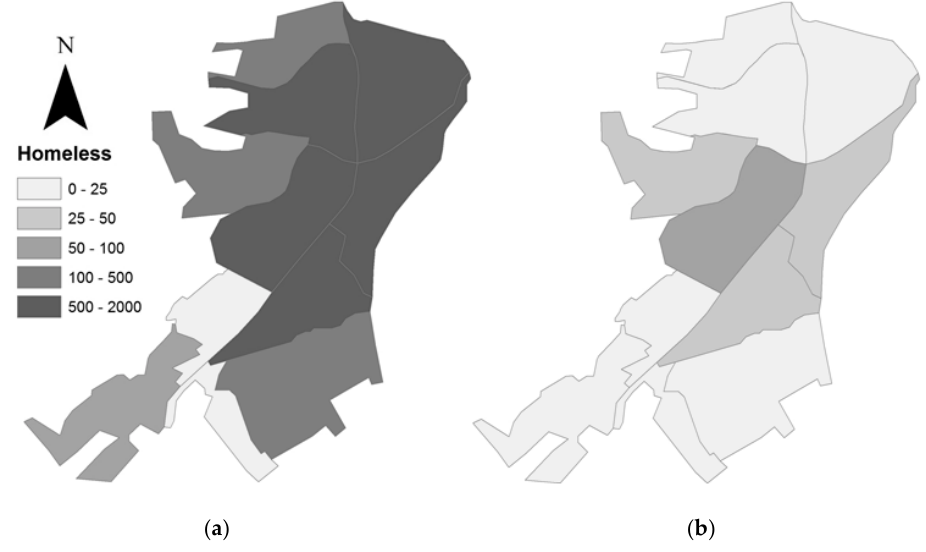
Figure 12. Number of homeless people for each district according to ( a ) the deterministic scenario and ( b) the probabilistic scenario.